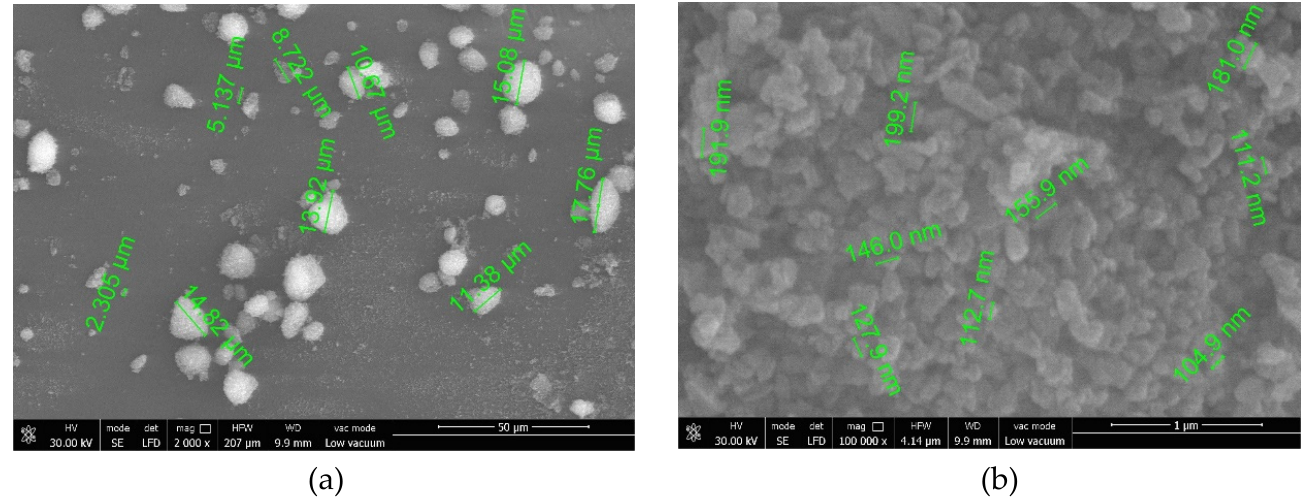
Figure 9. SEM images of SiC sample #1: ( a ) 10,000 times; ( b ) 80,000 times.